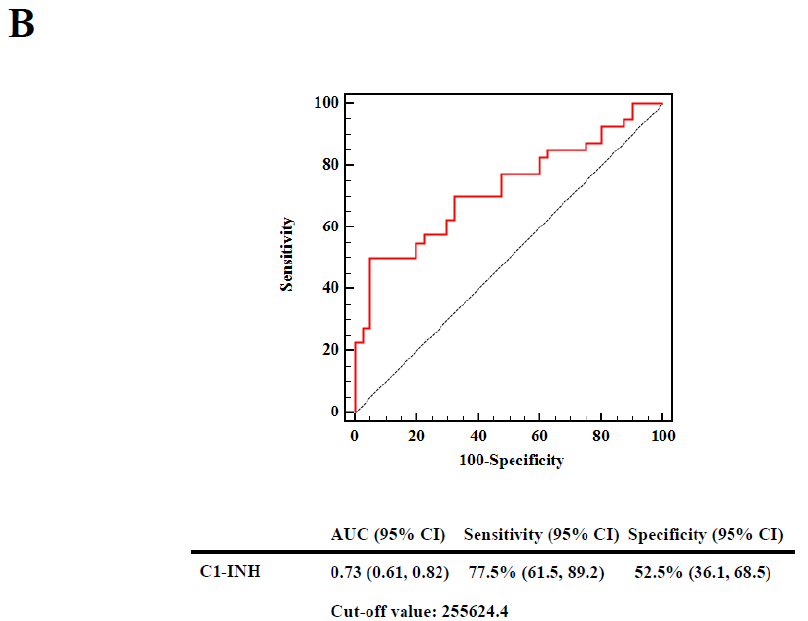
Figure 3. Serum protein levels of the C1-inhibitor (INH) were determined using an anti-C1-INH antibody through Western blotting using 40 pairs of individual serum samples in patients with systemic lupus erythematosus (SLE) versus healthy controls (HCs). Average blot densitometric values were examined using duplicate data (right, upper panel). A 6% sodium dodecylsulfate polyacrylamide gel electrophoresis (SDS-PAGE) gel and 2 µg of serum proteins were used for Western blotting. A duplicate SDS-PAGE gel was stained with Coomassie Brilliant Blue (CBB) as the loading control (right, bottom panel). The red arrow indicates the C1-INH ( A ). Receiver operating characteristic (ROC) curves were plotted according to blot densitometry of the C1-INH. The area under the ROC curve (AUC), sensitivity, and specificity were further calculated ( B ).